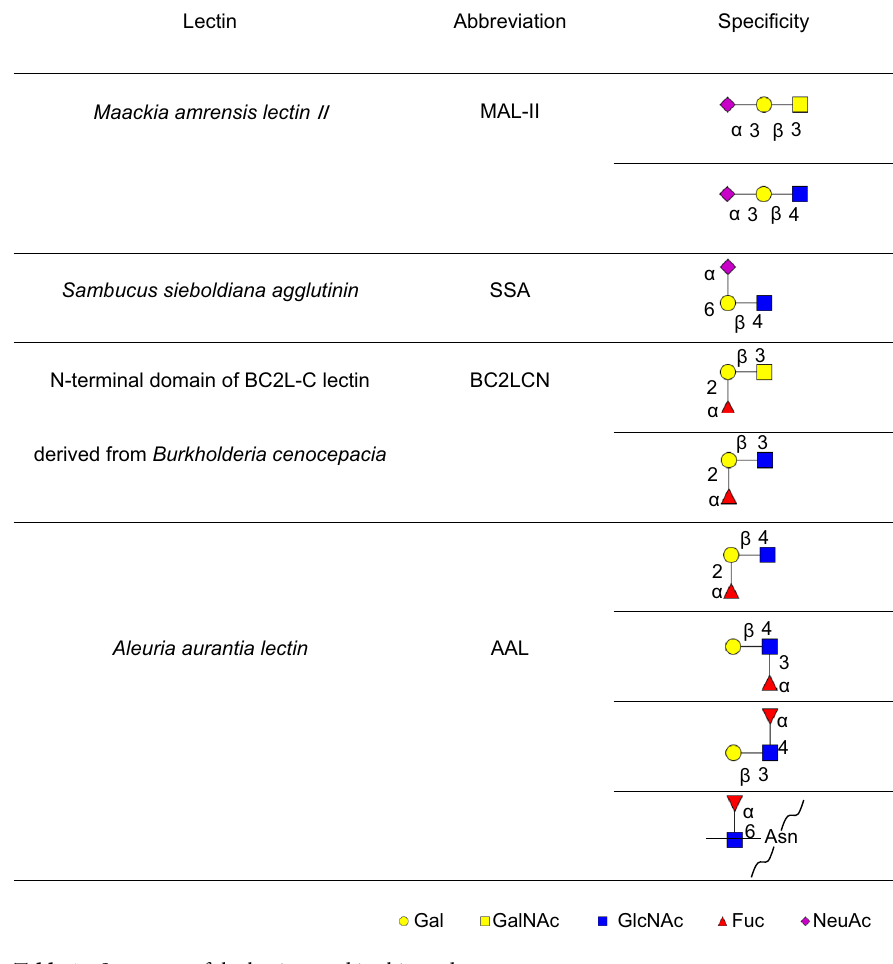
Table 1. Summary of the lectins used in this